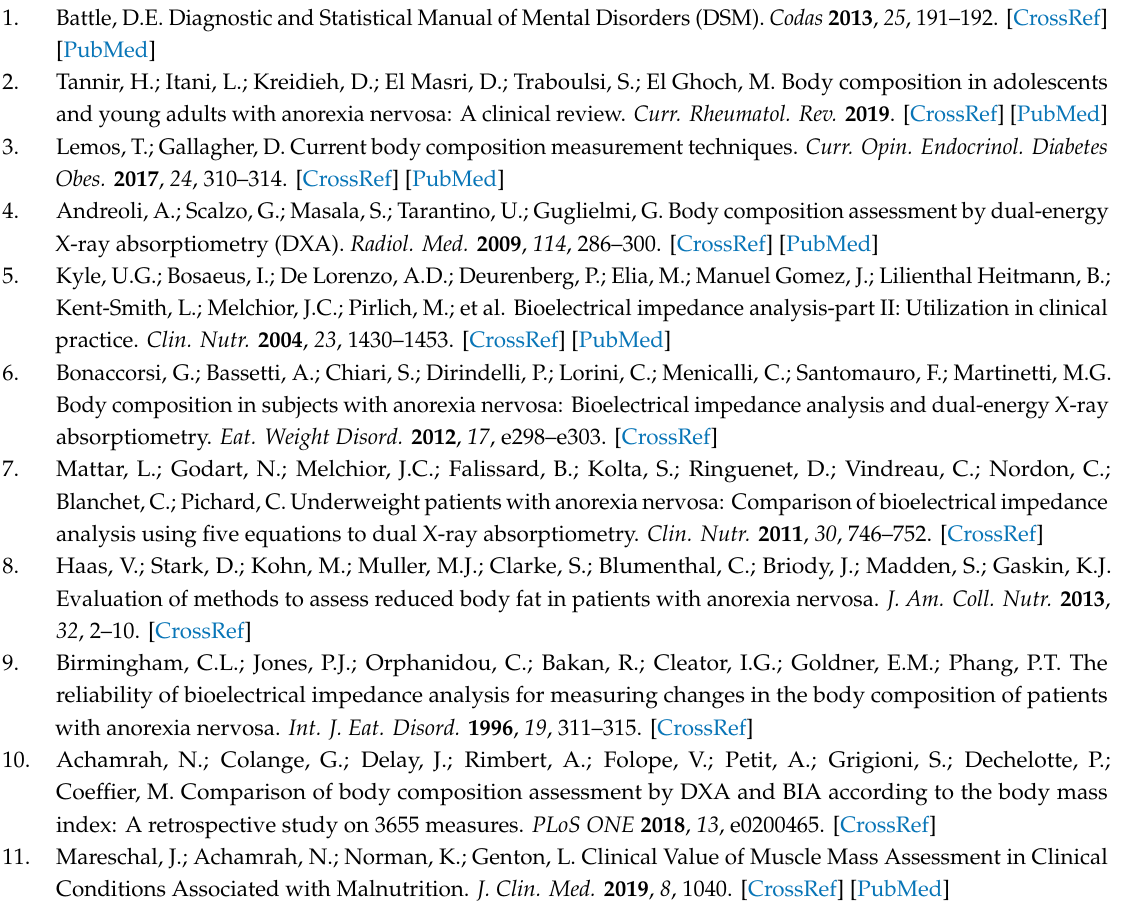
Figure S1: Participants Flow